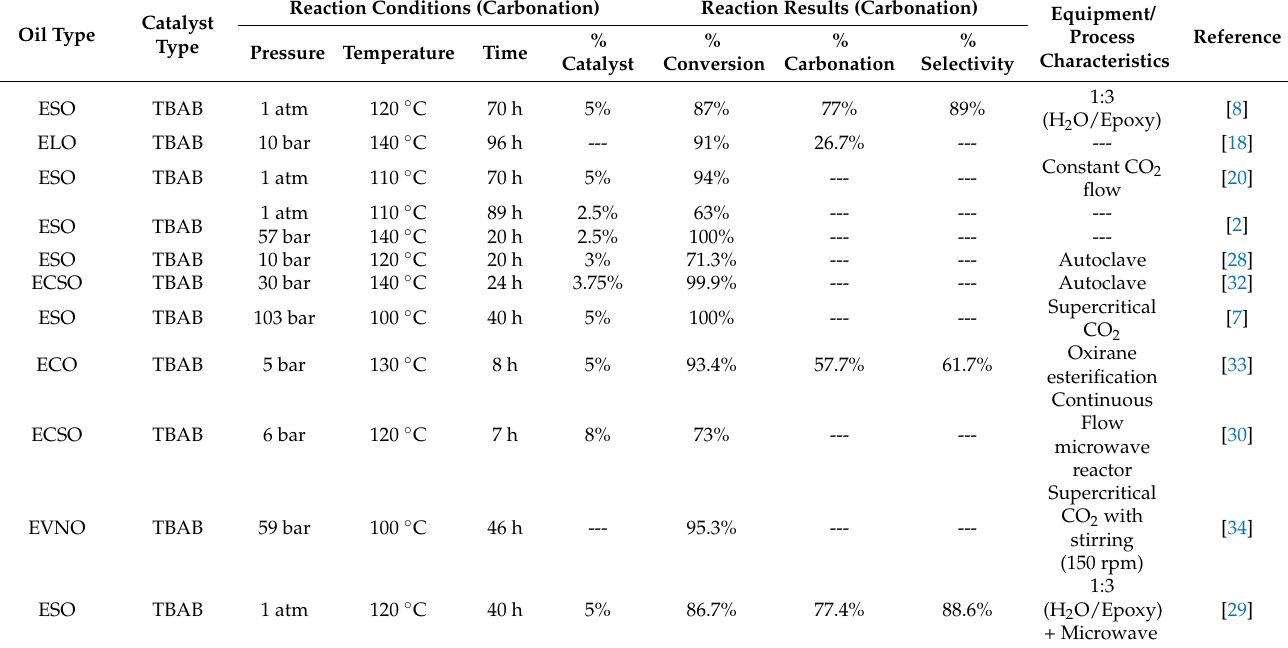
Table 1. Literature Reports of Carbonation Reaction in Epoxidized Vegetable Oils (EVOs) Using Tetrabutylammonium Bromide